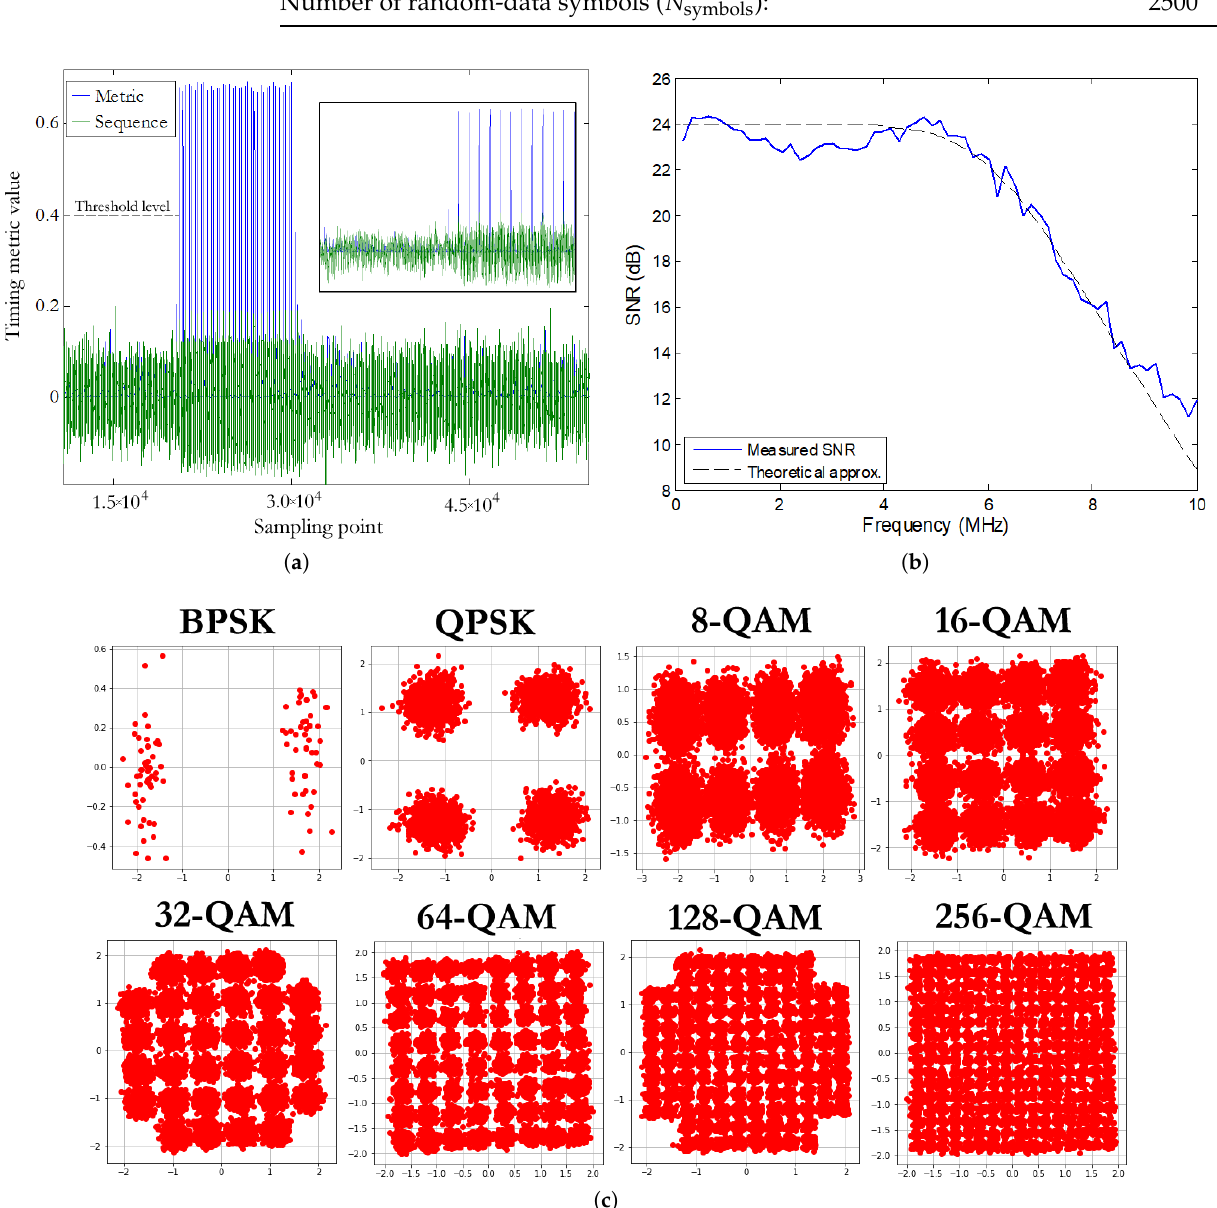
Figure 13. Experimental results obtained at the center of the mockup receiver plane when the four lamps transmit the same information: ( a ) Timing metric during a transmission. ( b ) Average of measured SNR. ( c ) Symbol constellations at